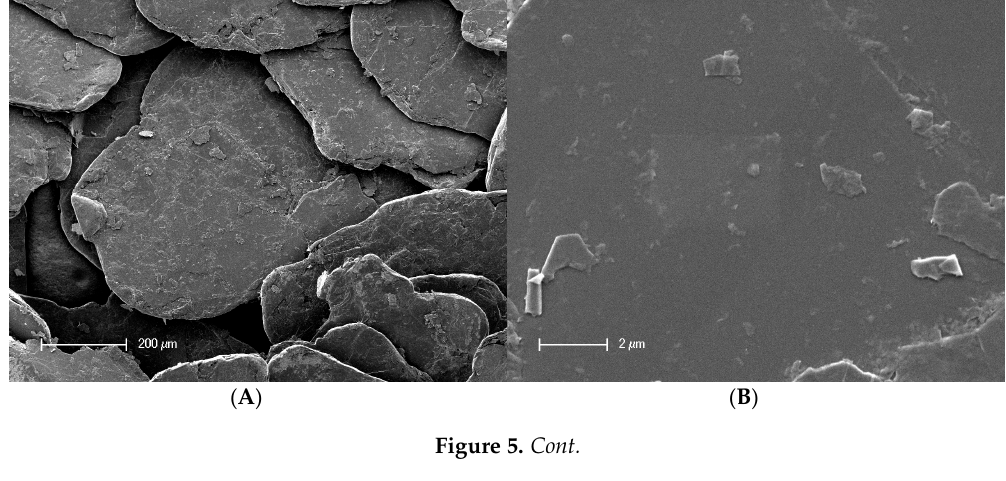
Figure 4. Scanning electron micrographs taken of the 10 vol% fluorine treated sample.